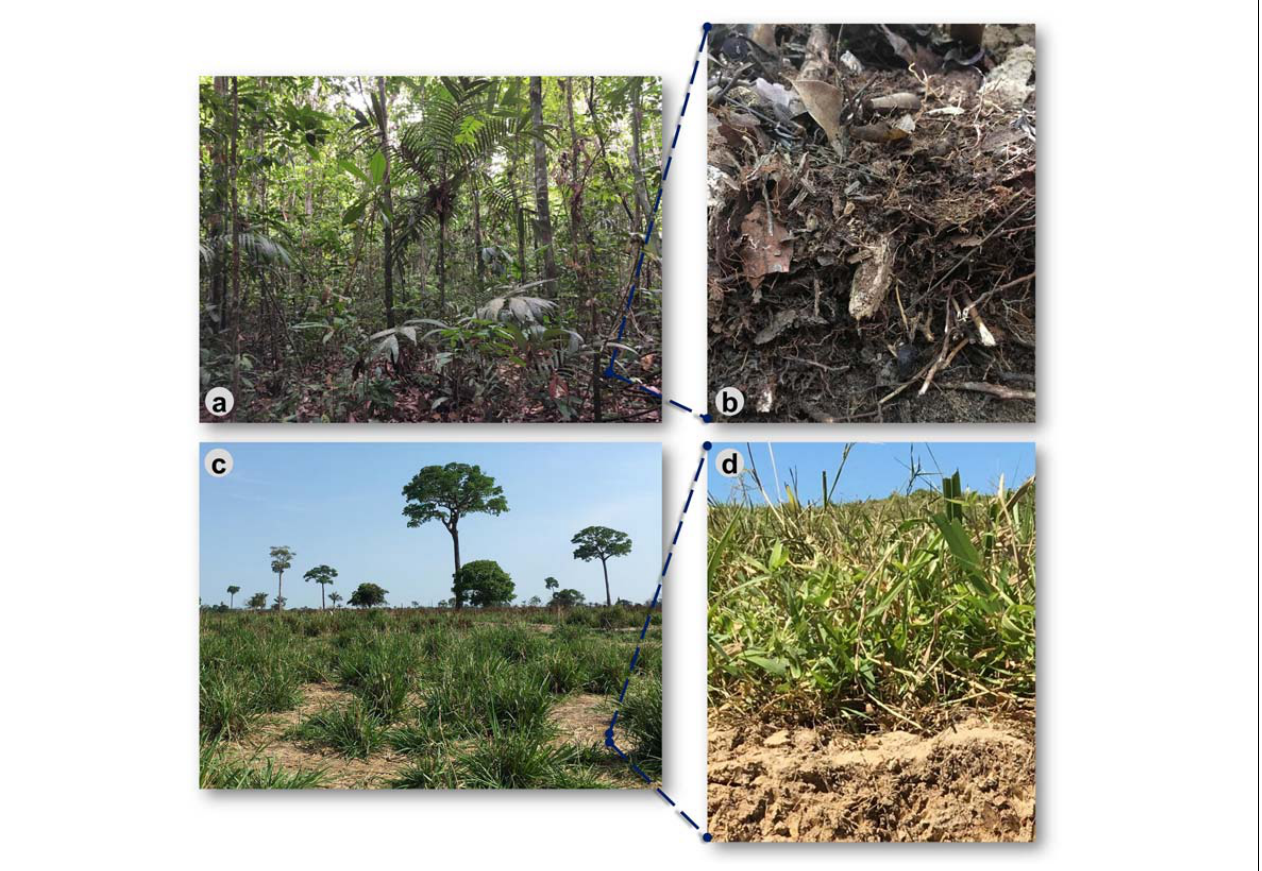
FIGURE 1 | Illustrative representation of the evaluated land uses in the Brazilian Western Amazonia, focusing on the forest floor’s decay after converting the forest to pasture. (a) Rainforest where the (b) forest floor (litter and the root layer on top of the mineral bulk soil) were sampled; (c) pasture systems, and (d) their respective soil surface with a reduced presence of organic